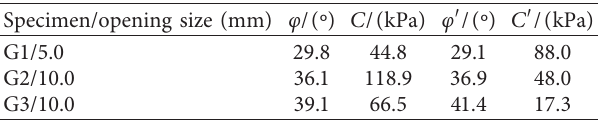
Table 3: Summary of testing results for direct shear tests and triaxial compression